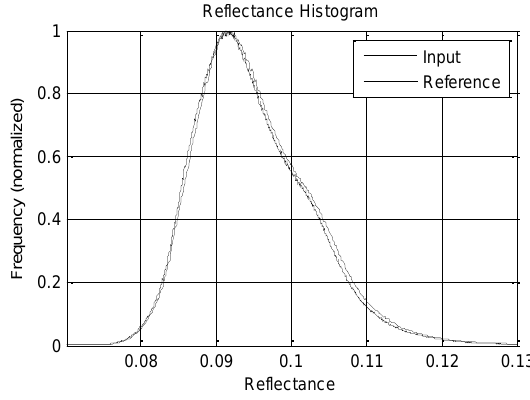
Figure 5. Reflectance histogram of a real-time product compared to a LPGS-generated